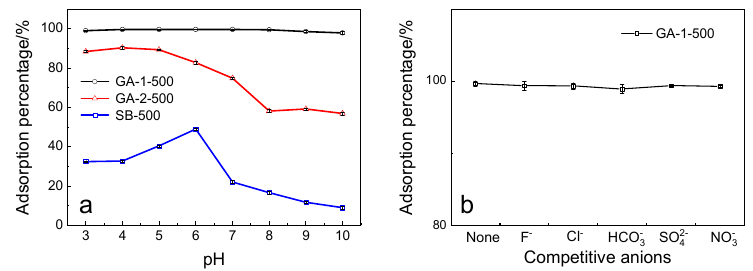
Figure 9. Effect of ( a ) initial pH and ( b ) competitive anions on phosphorus removal. Figure 9. E ff ect of ( a ) initial pH and ( b ) competitive anions on phosphorus